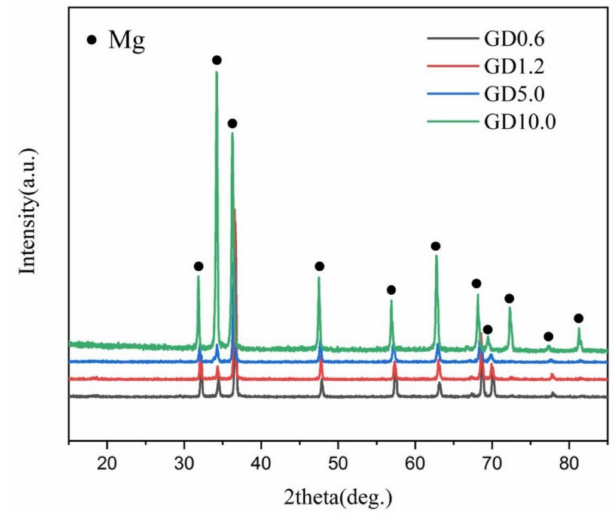
Figure 3. XRD pattern of the as-extruded Mg–Gd–Dy–Zr alloys. As XRD analysis has limited ability to detect the low content intermetallics in mag- nesium alloys, the SEM test was adopted to observe the second phase of alloys after the homogenization and extrusion process. Figure 4a–d shows the SEM microstructure of the as-extruded Mg–Gd–Dy–Zr alloys. It can be seen that there were a few very small second- phase particles dispersed in the α -Mg matrix and at the grain boundaries, even for the low RE concentration samples. The particles also increased slightly with the increase in RE content. In addition, the EDS analysis was conducted for the red selected area in Figure 4d and the distribution of elements is shown in Figure 4e. The small rectangular white region, irregularly shaped white region, and the matrix are labeled with A, B, and C, respectively. For region A, the Gd and Dy contents were 23.09 at% and 20.6 at%, respectively, which were relatively higher than the stoichiometry of the Mg 5 RE compound, a typical second phase considered in previous Mg–RE publications [44,45]. For region B, the relative low RE size was less than 5 µ m. The low Gd and Dy content in region C indicate that RE remained